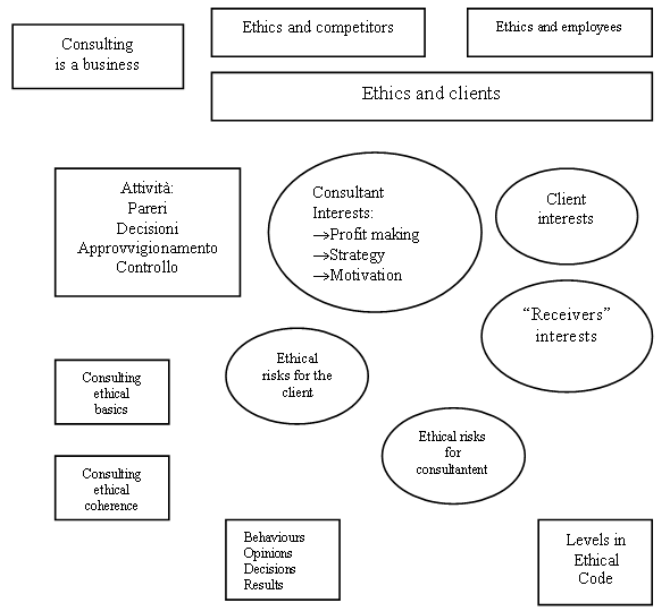
Figure 2: Synthetic Framework of Ethics in Management